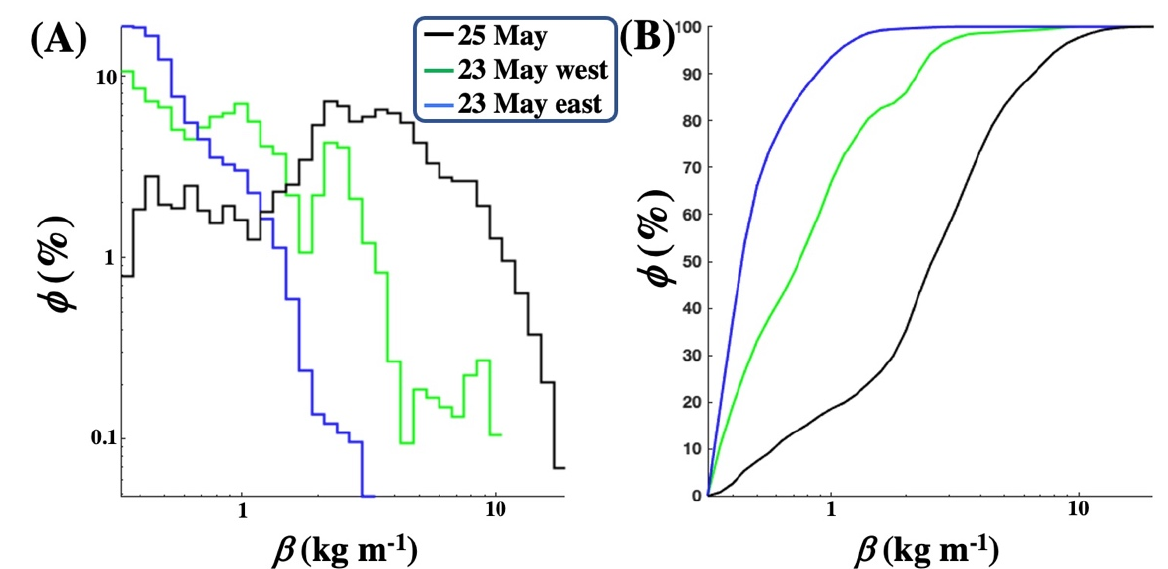
Figure 13. ( A ) Slick linear oil mass, β , (kg m − 1 ) normalized probability distribution, Φ , (normalized to kg m − 1 bin − 1 ) for oil streamers from 23 May and 25 May. Data key on figure. See Figure 10A for the east and west slicks on 23 May. ( B ) Cumulative plot of β .